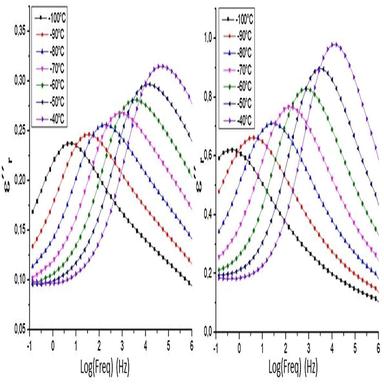
ε″ vs frequency graphs at low temperatures showing sub-Tg transitions for PCNMeiT (A) and PDCNiT (B).